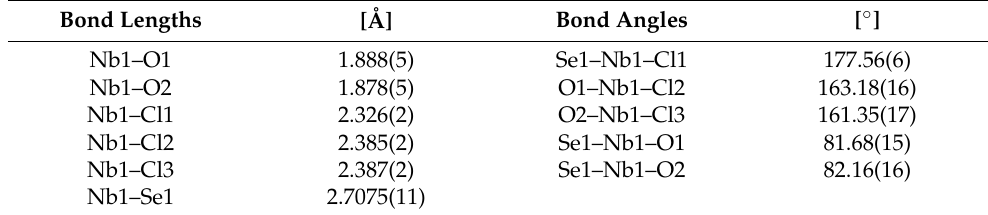
Table 1. Selected bond lengths [Å] and bond angles [ ◦ ] of 4